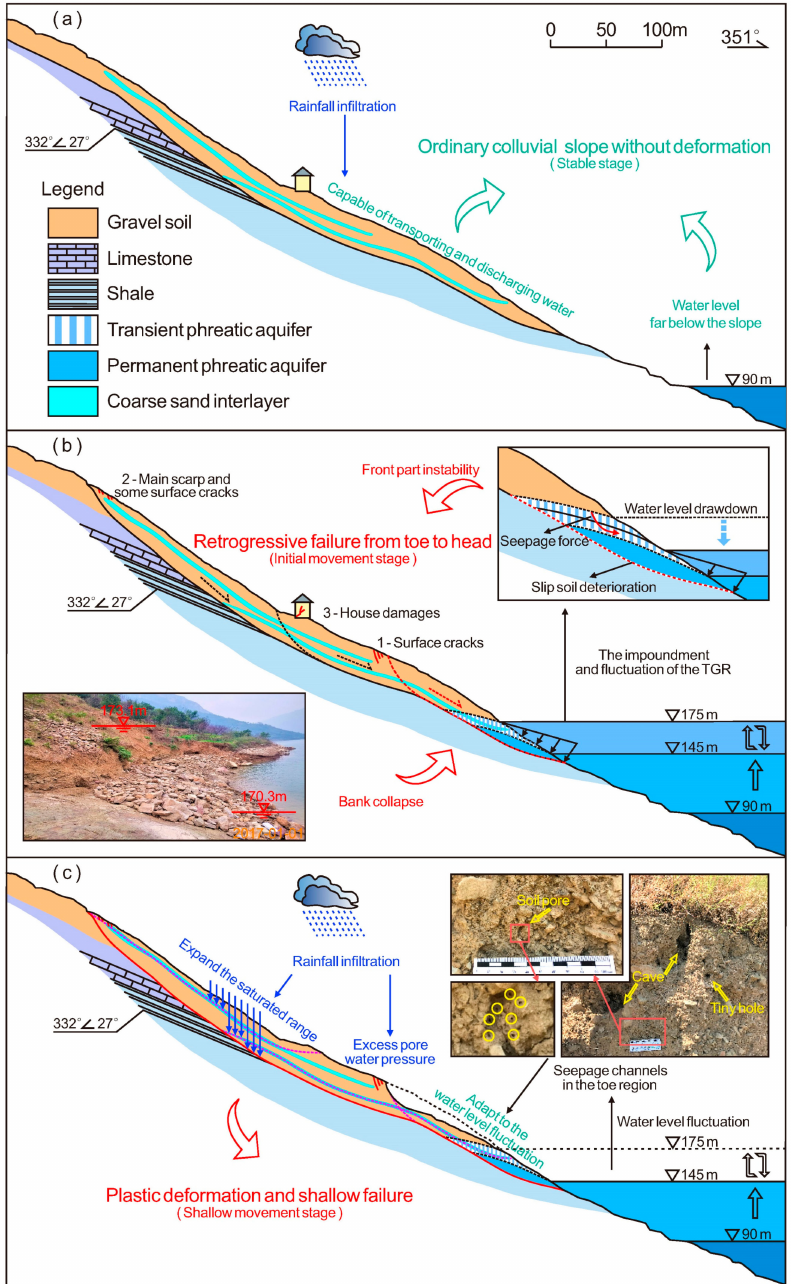
Figure 17. The evolution process of Ganjingzi landslide: ( a ) stable stage, ( b ) initial movement stage with retrogressive creep deformation, and ( c ) shallow movement stage with plastic deformation and shallow